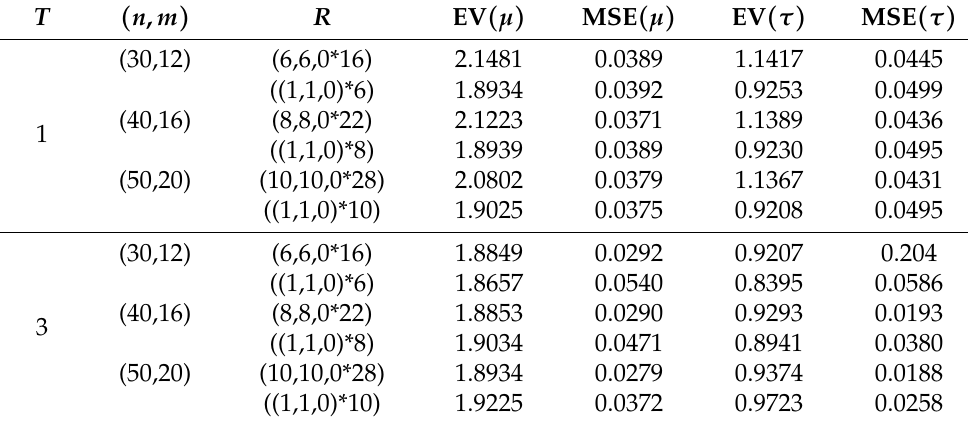
Table 1. The MLE results of µ and τ .